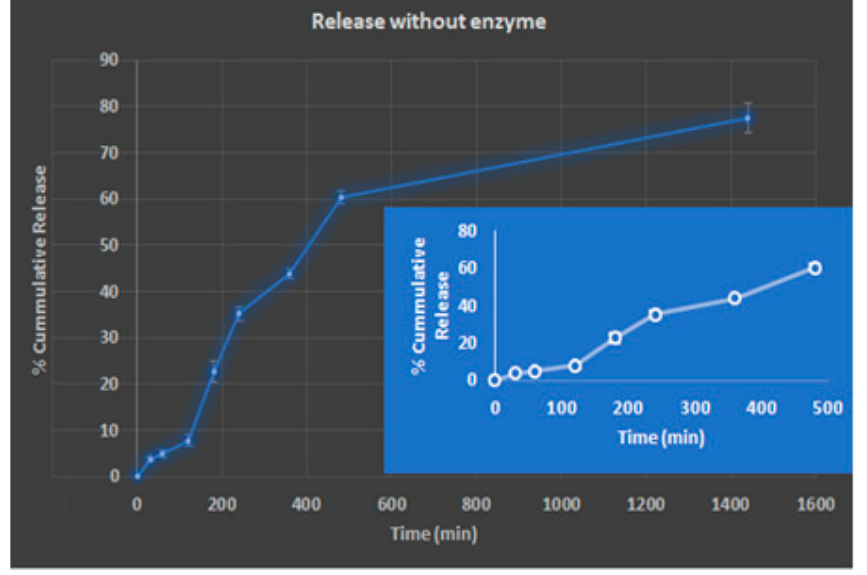
Figure 9. Graph of cumulative percentage drug release over time.